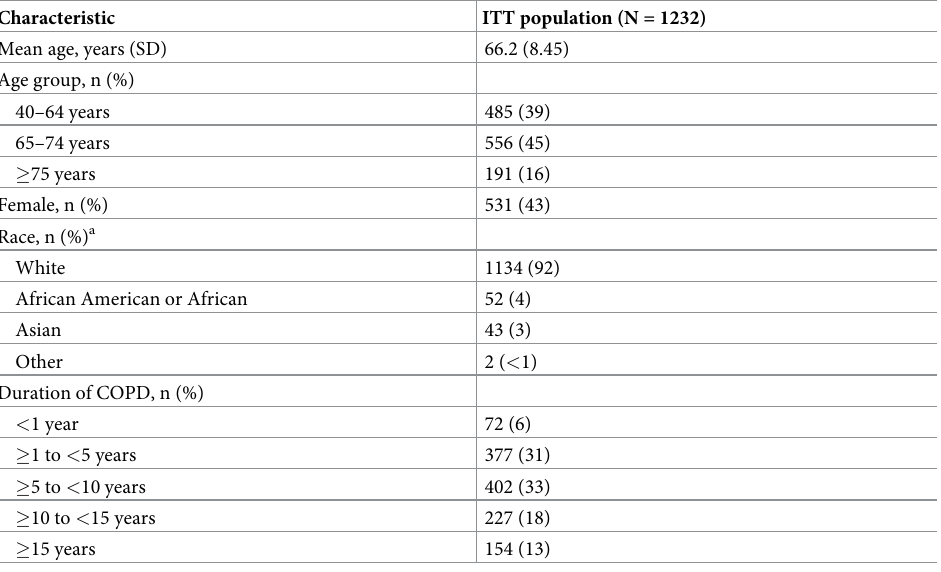
Table 2. Baseline patient demographics and clinical